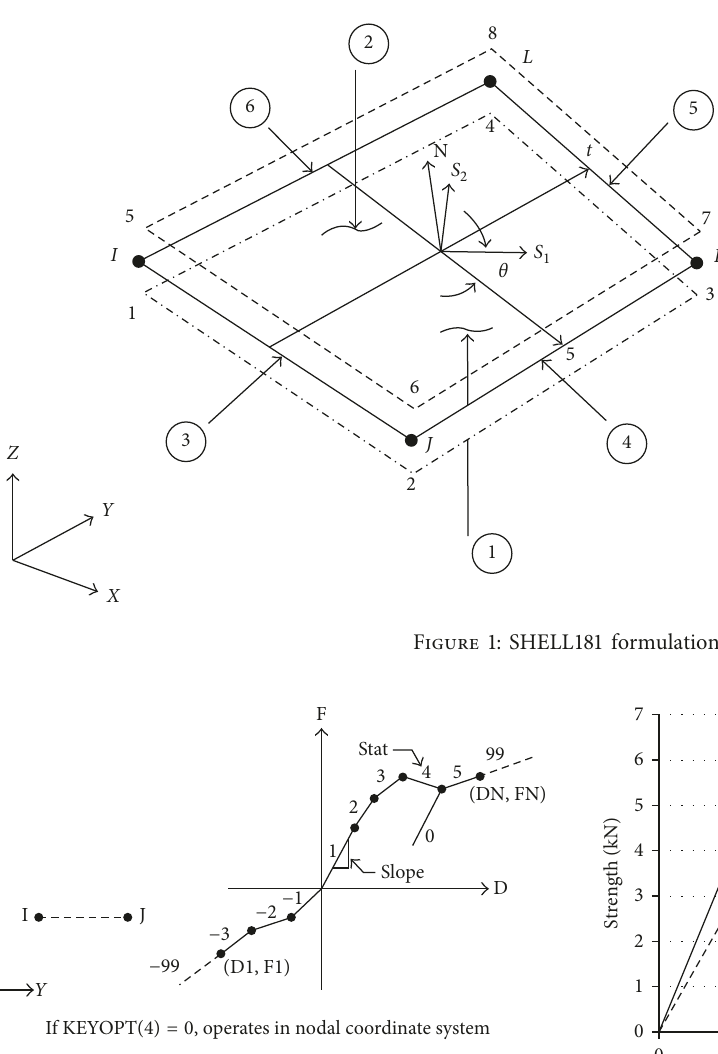
Figure 2: COMBIN39 formulation.